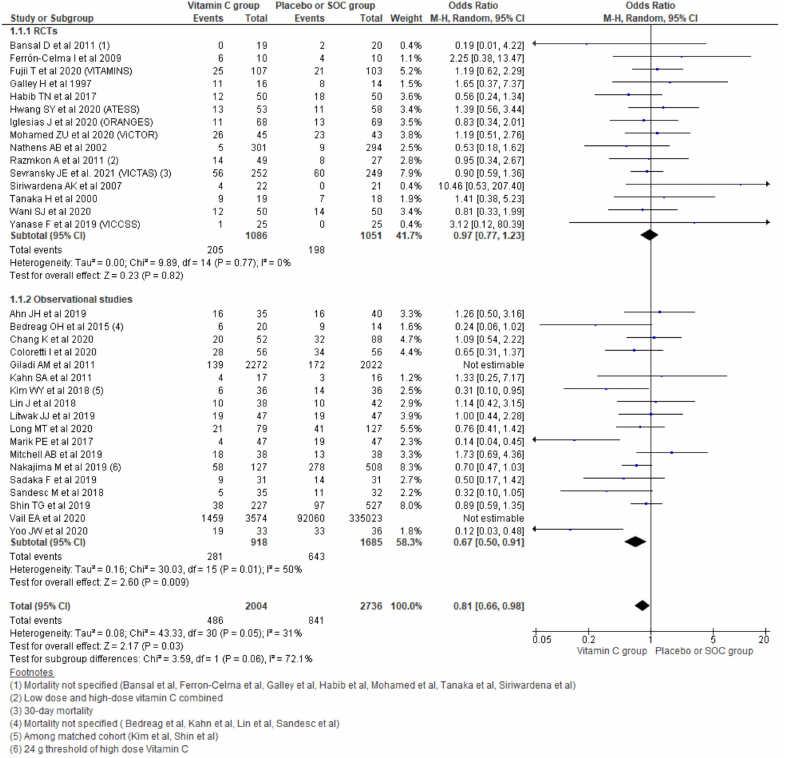
Figure 3. Forest plot showing overall hospital mortality using random-effect